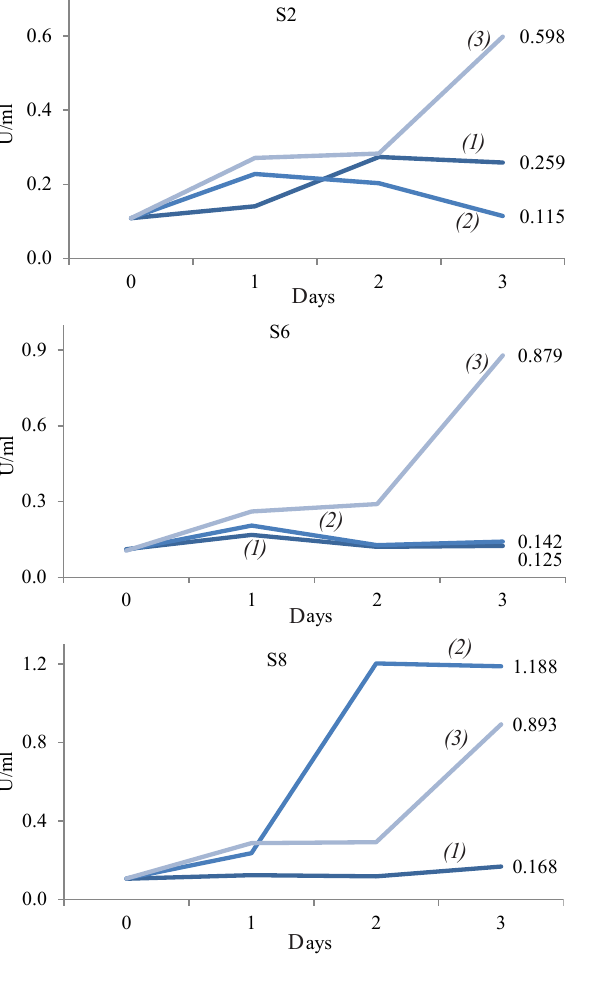
Figure 3 Cellulose-degrading enzyme activity: (1) – 27°C, (2) – 37°C, (3) –